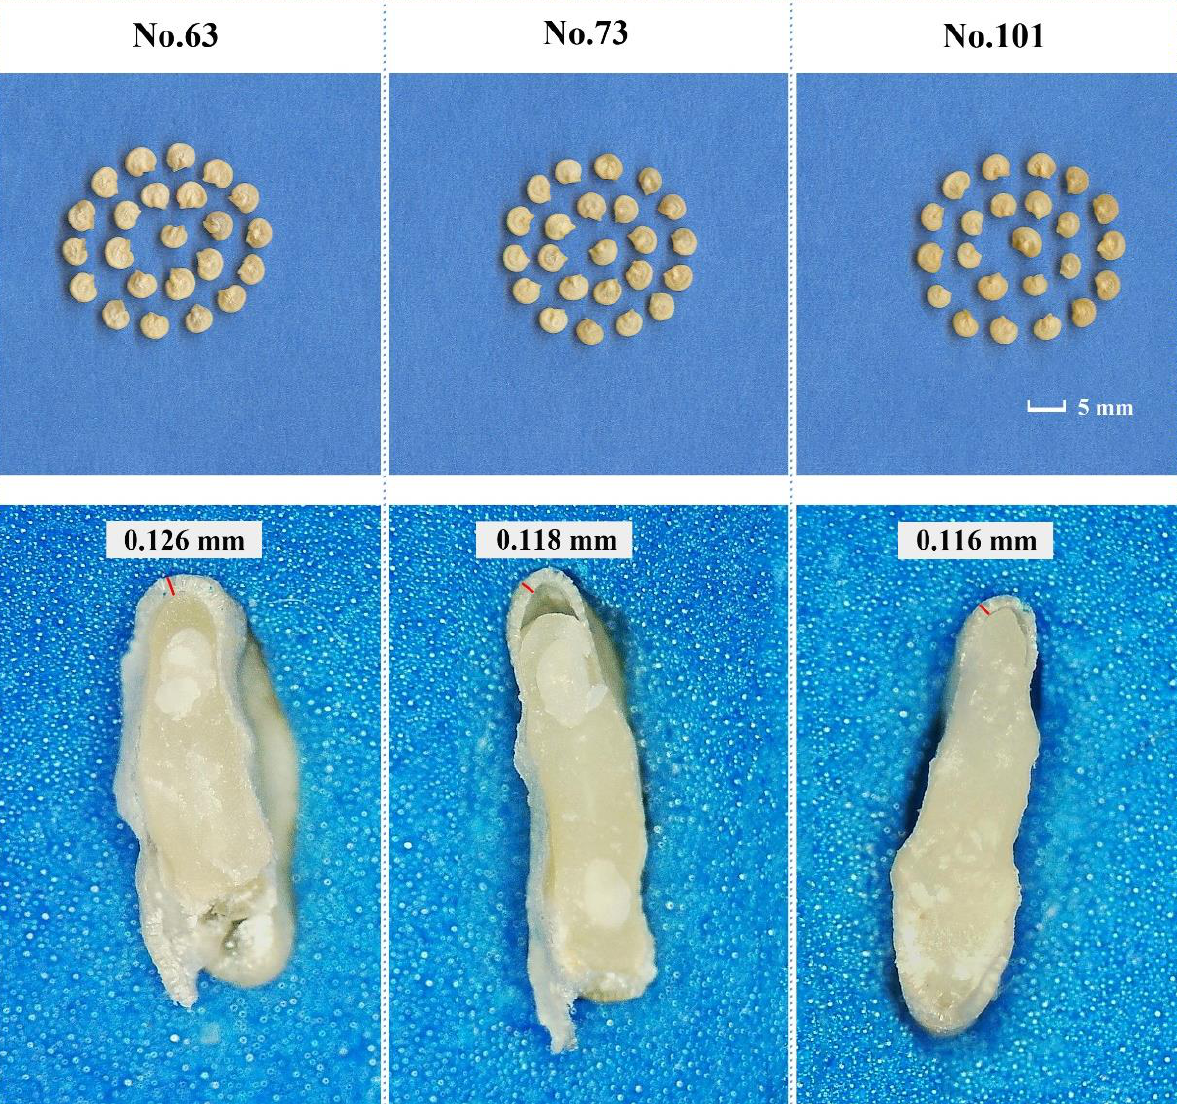
Figure 1. The appearance and seed coat structure of pepper seeds of three varieties, No.63, No.73, and No.101.